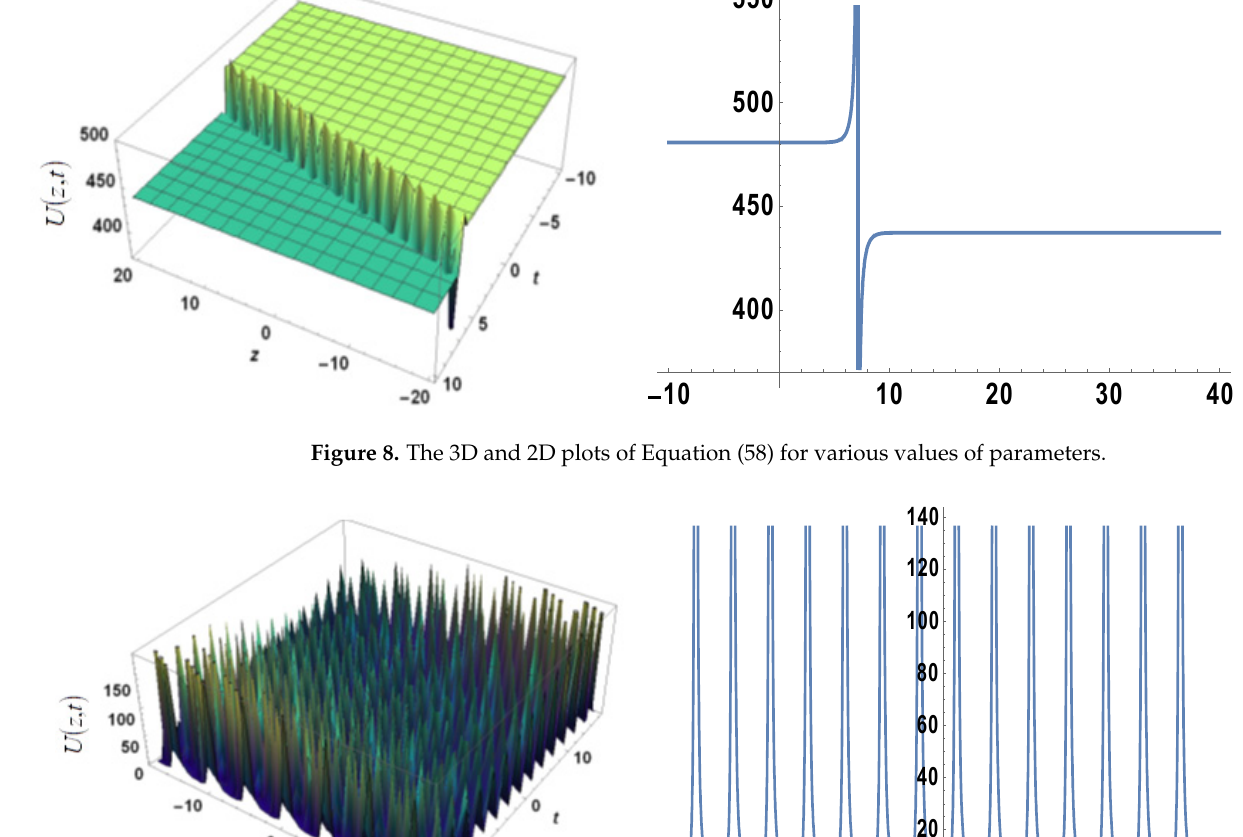
Figure 7. The 3D and 2D plots of Equation (57) for various values of parameters.